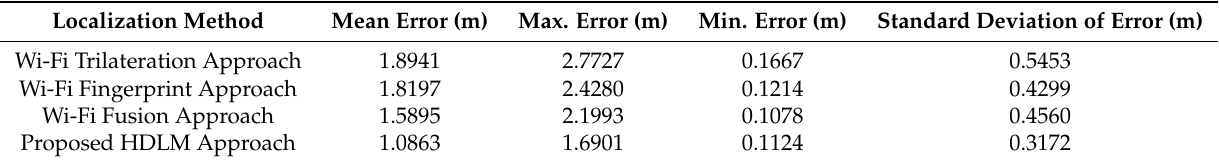
Table 3. Performance of different localization approaches.